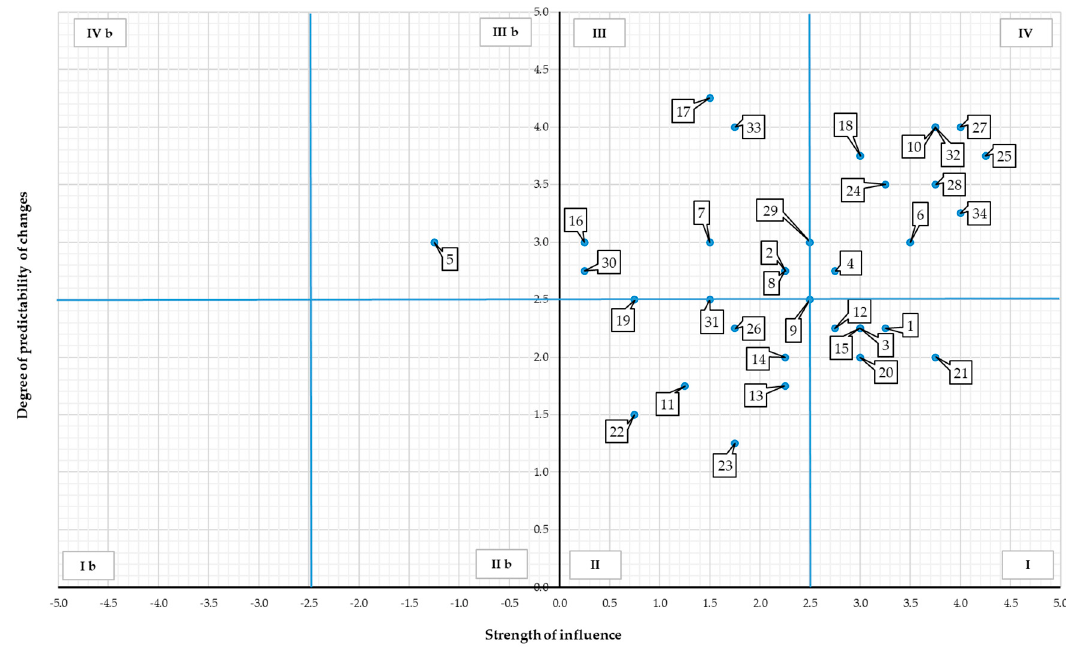
Figure 5. Stakeholder map in the innovation ecosystem: strength of influence—degree of predictability of changes.